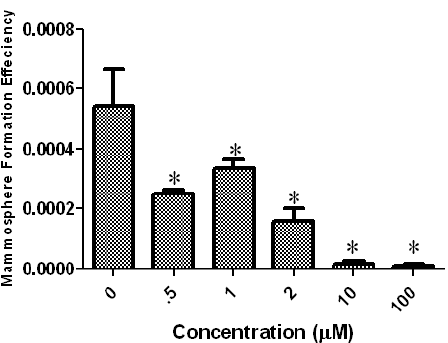
Figure 3. Inhibitory effect of Tetrandrine on mammosphere formation ex vivo. Cancer cells purified from fresh patient pleural fluid were seeded in mammosphere media with indicated dose of tetrandrine. In the end, mammospheres were stained with MTT and counted as described. Asterisks indicate P < 0.05 compared to control. Error bars represent standard